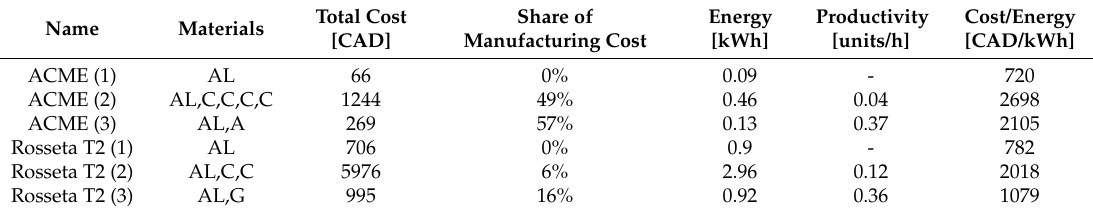
Table 9. Summary of case study results: Optimal material choice and objective values for different rotor designs. (1): lowest costs, (2): highest energy, (3): most cost-efficient composite rotor, AL: